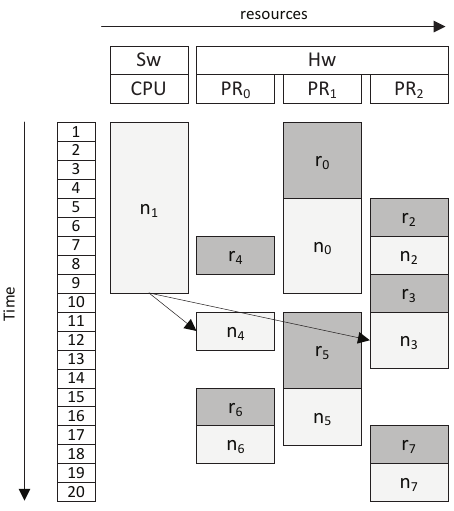
Figure 3. The Sw/Hw partitioning and scheduling result of the example